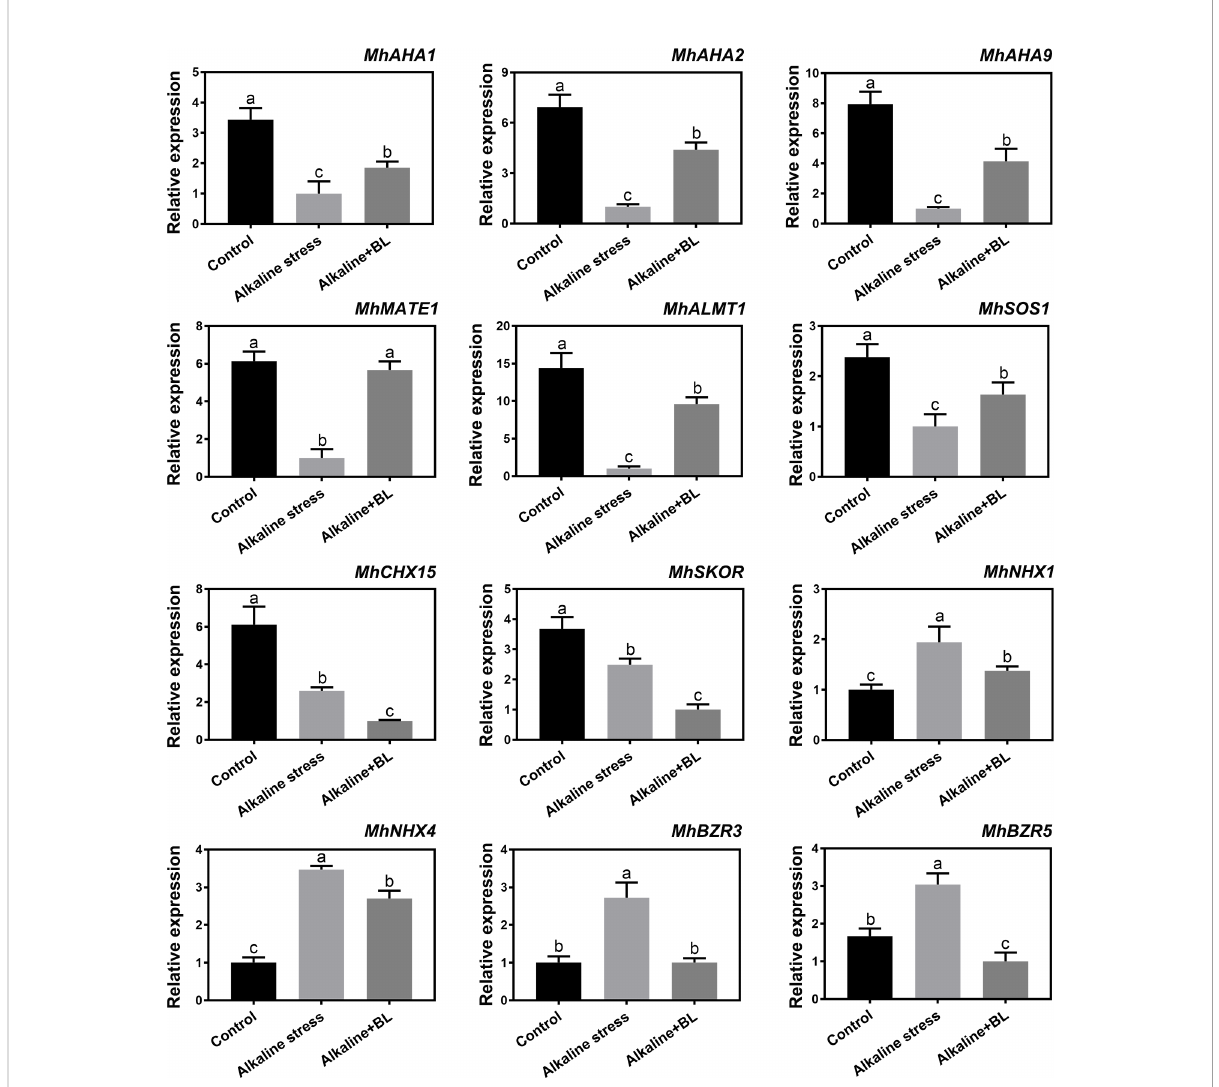
FIGURE 8 The expression of the 12 candidate genes ( MhAHA1 , MhAHA2 , MhAHA9 , MhMATE1 , MhALMT1 , MhSOS1 , MhCHX15 , MhSKOR , MhNHX1 , MhNHX4 , MhBZR3 and MhBZR5 ) in roots under alkaline stress and exogenous BL treatment for 15 days. The data represent the mean ± SD of biological replicates. Different lowercase letters indicate signi fi cant differences according to Fisher ’ s least signi fi cant difference ( P <